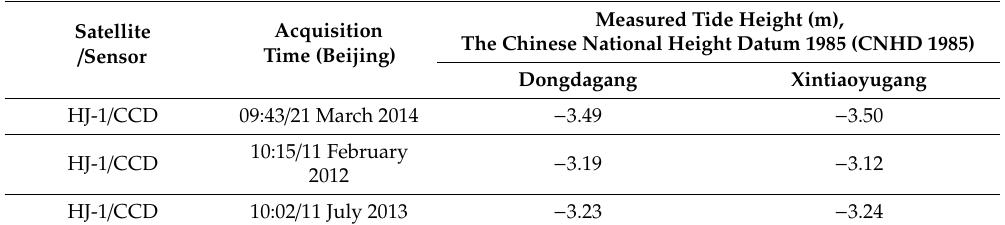
Table 1. Satellite remotely sensed data and in situ water level data.